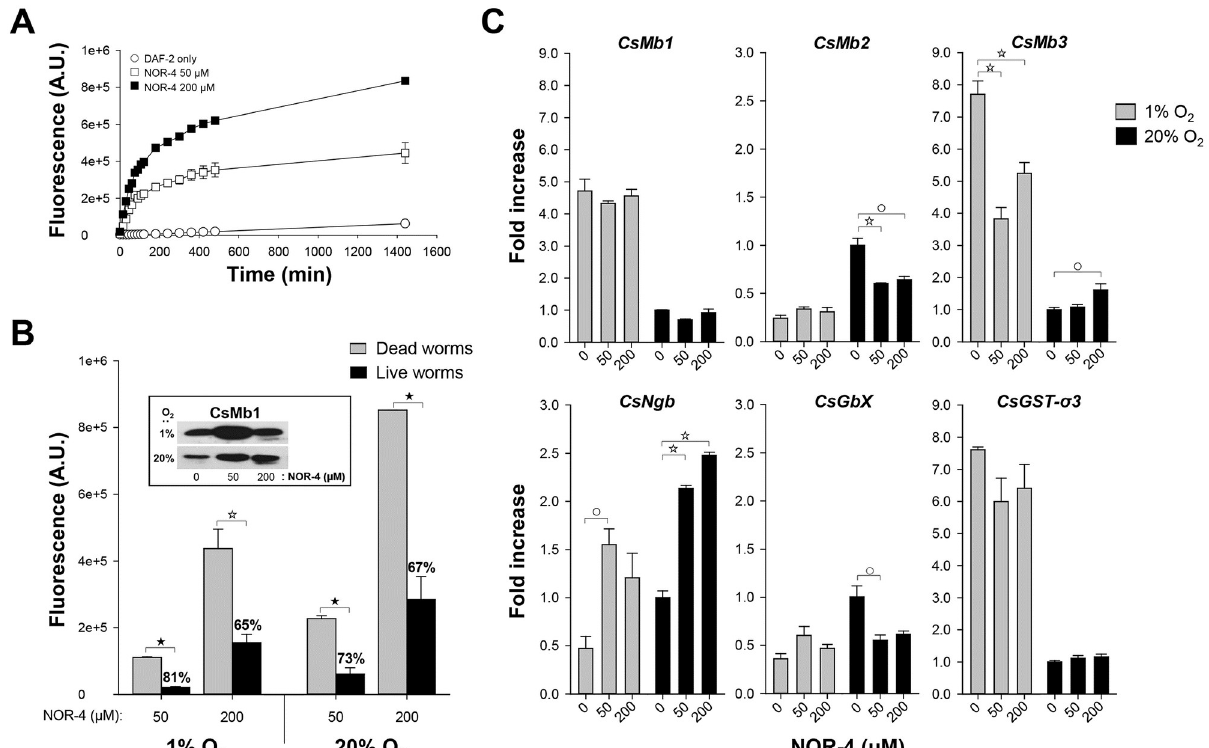
Fig 5. Effect of nitric oxide (NO) on the expressions of the Clonorchis sinensis globin genes. A. The relative amounts of NO released from NOR-4 in the RPMI-1640 medium was measured using the DAF-2 fluorescence assay method in relation to the incubation times. A.U., arbitrary unit. B . Live or dead C . sinensis adults were incubated for 24 h in the RIMI-1640 medium supplemented with NOR-4 and DAF-2 under 1% or 20% oxygen conditions. The fluorescence values of the conditioned media, which were measured using the DAF-2 method, were serially subtracted from those of NOR-4- and DAF-2-only media (n = 3, mean ± SD). The percentages on the histograms of the live-worm groups indicate the degree of fluorescence reduction compared to those in the dead-worm groups. $ P < 0.01; $ P < 0.001. The results of western blot analysis of the conditioned media (20 μ L/well) with an anti-CsMb1 antibody are shown in the inset image. C . The expression levels of the globin genes were examined in the C . sinensis worms described in panel B by performing qRT-PCR. The fold increases were calculated by comparing the values of the experimental groups with those in the 20% worm- only control group (n = 3, mean ± SD). � P < 0.05; $ P <